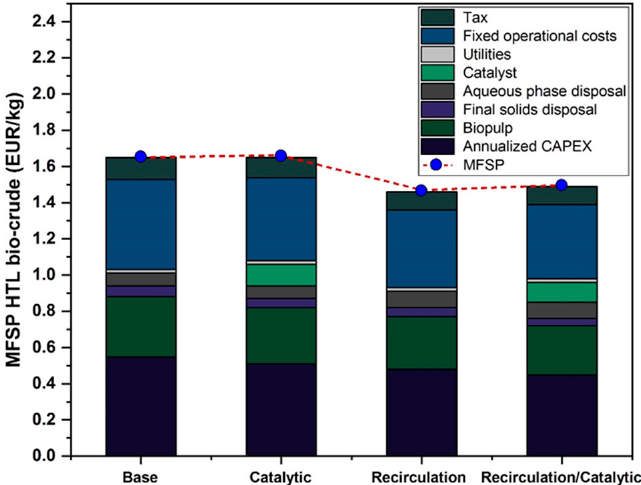
Figure 6. Effect of K 2 CO 3 addition and aqueous phase recirculation on the final MFSP.